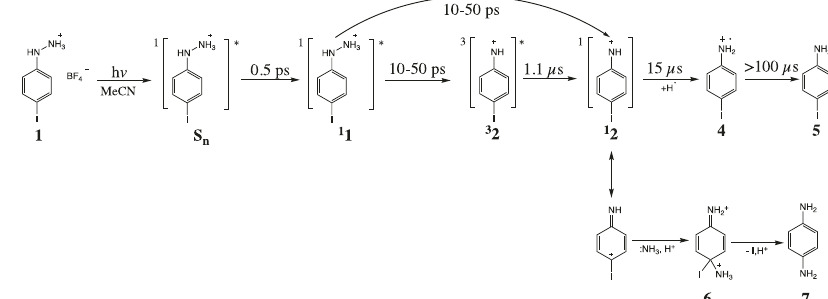
Fig. 6 The proposed photoinduced reaction mechanisms after 267 nm photoexcitation of 1 in MeCN. After the photoexcitation, the 1 1 partitions between heterolysis to generate the singlet nitrenium ion 1 2 and intersystem crossing (ISC) as a result of the heavy iodine atom followed by a spontaneous heterolysis process to generate the triplet nitrenium ion 3 2 . The 3 2 undergoes ISC with in 15 μ s to generate the 1 2 , which ultimately undergoes proton and electron transfer to generate a long-lived radical cation 4 that further reacts on the microsecond time scale to generate the reduced p-iodoaniline 5 as the major photoproduct.